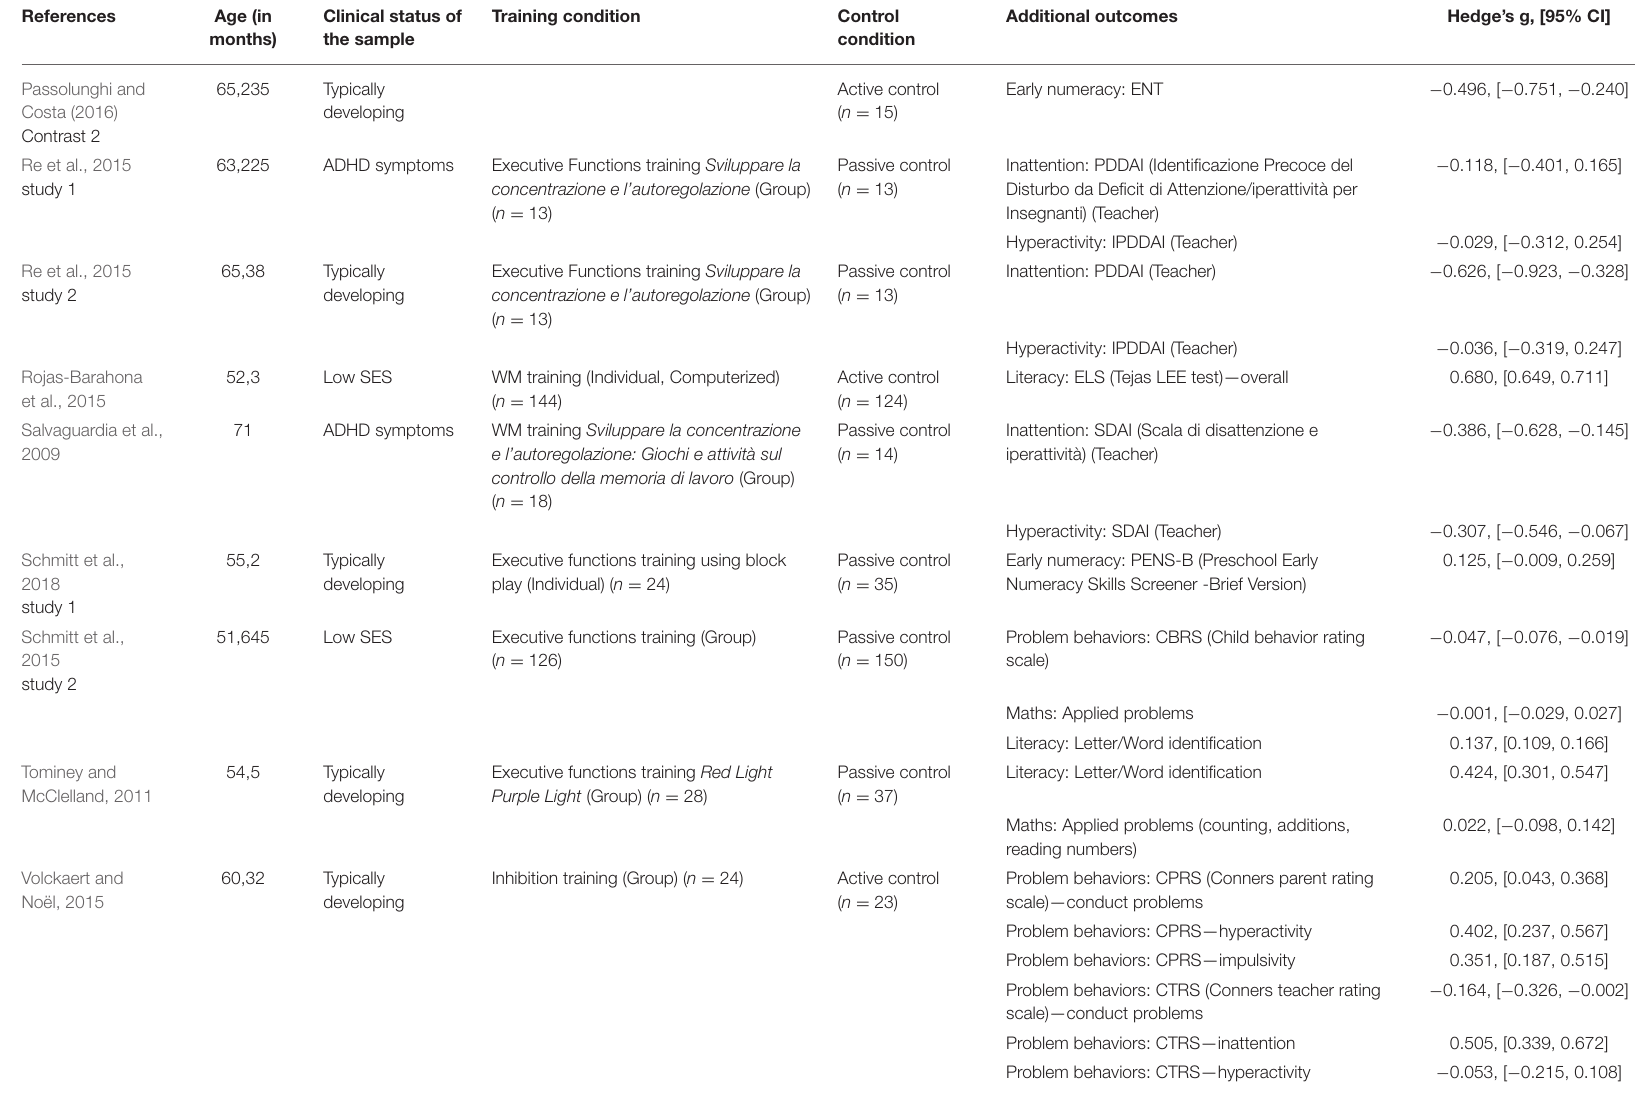
Italic text indicates the commercial name of that training